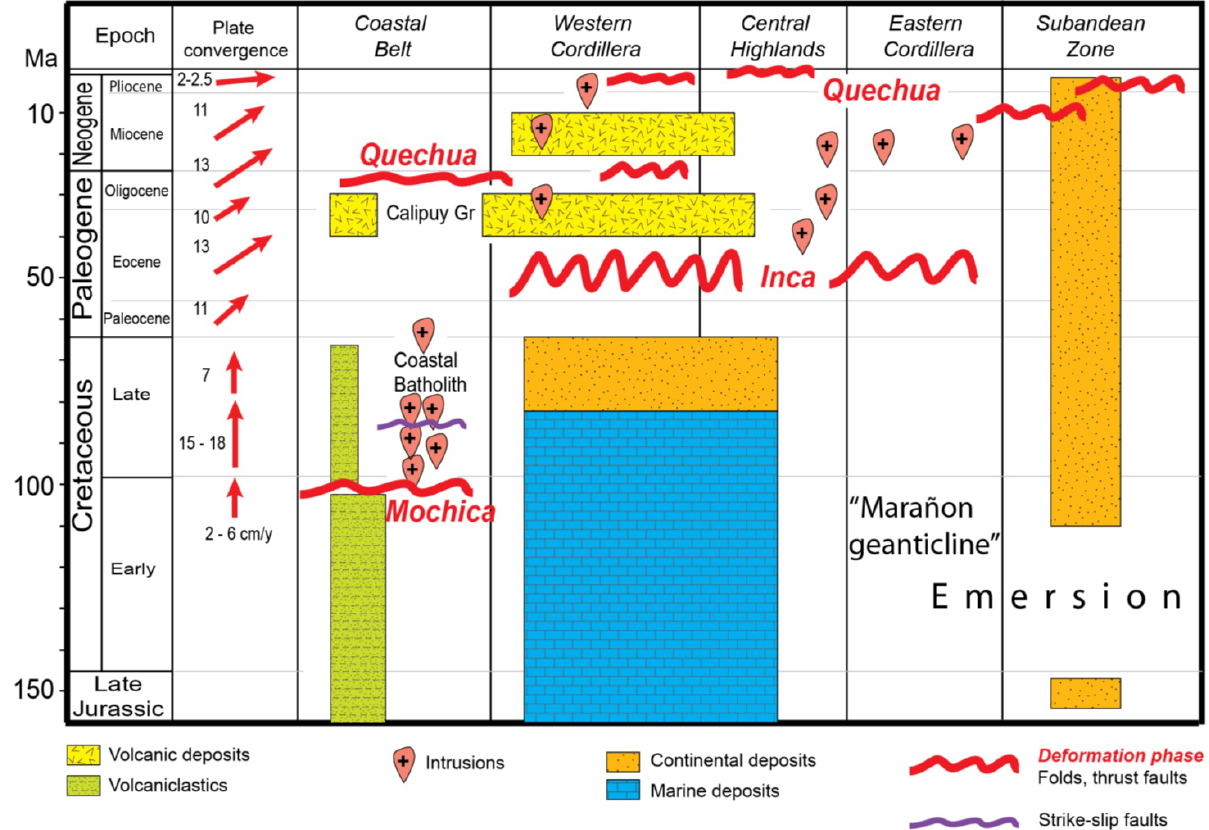
Figure 20. Orogenic timetable for the Central Andes of Peru. See text for discussion and references used for the compilation of convergence